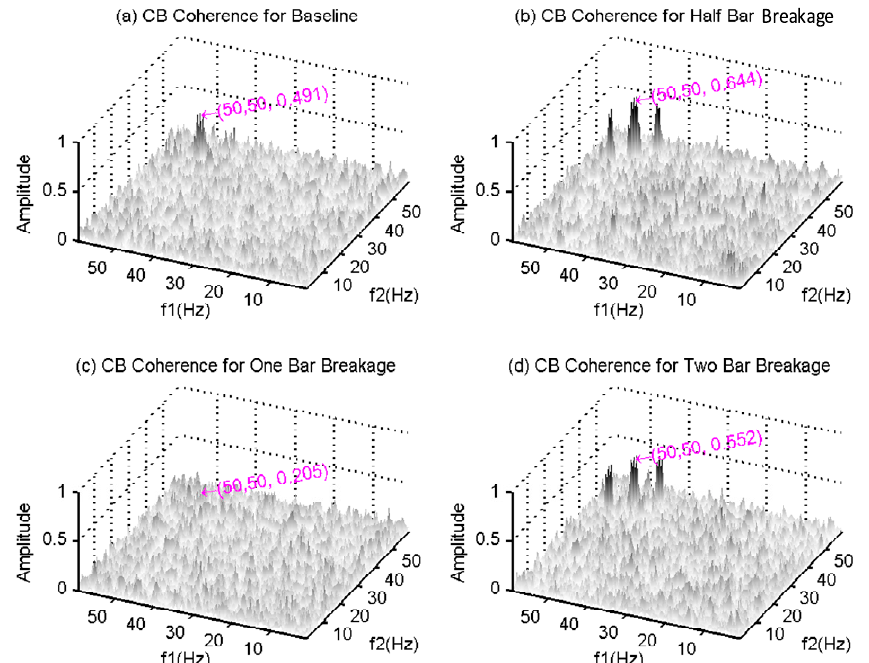
Figure 7. CB coherences for baseline motor and BRB cases.